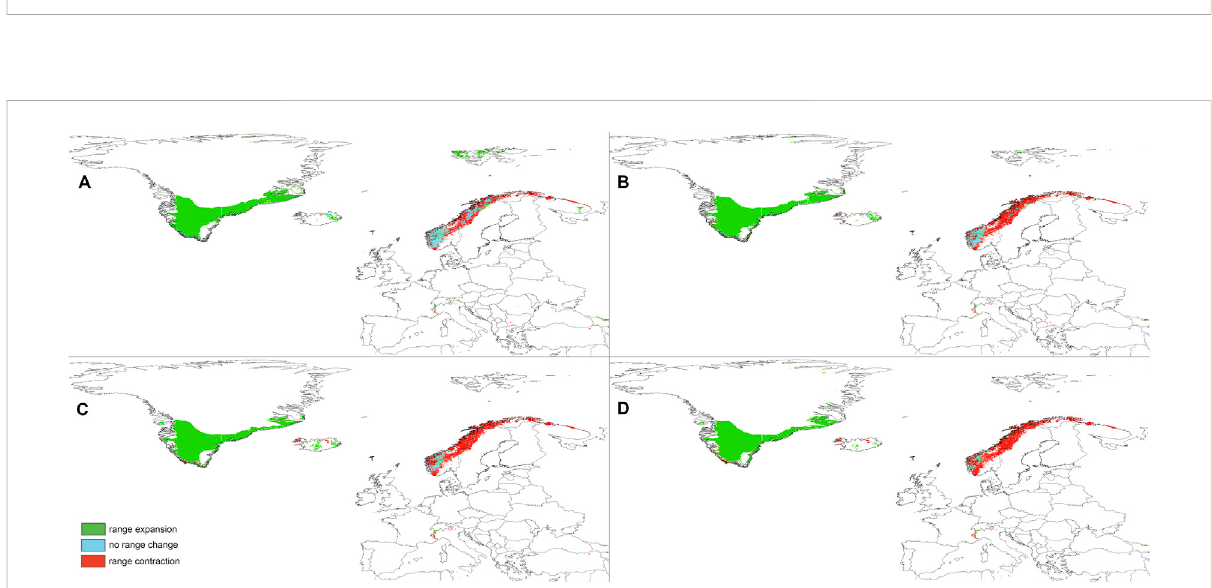
FIGURE 7 Changes in the distribution of suitable niches for P. albida ssp. straminea predicted under SSP1-2.6 (A) , SSP2-4.5 (B) , SSP3-7.0 (C) , and SSP5- 8.5 (D)